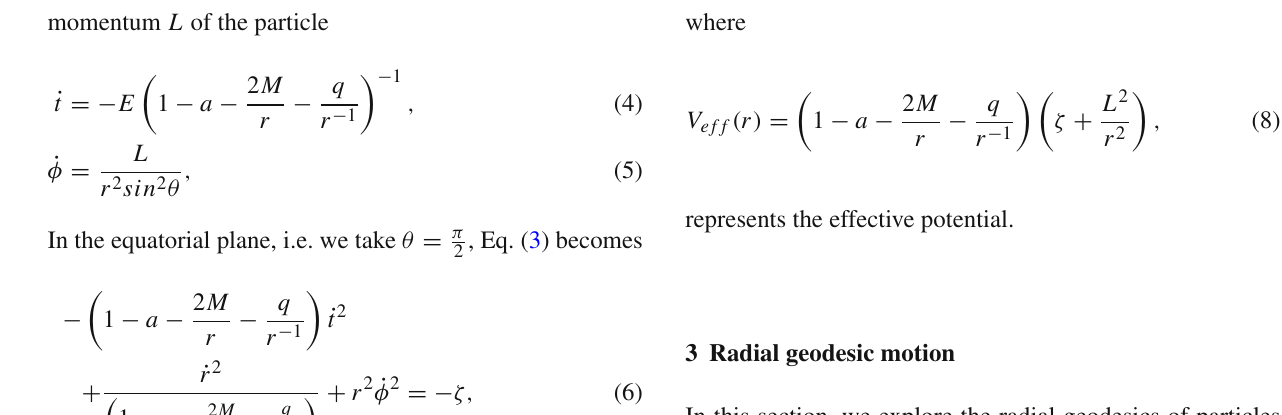
Fig. 2 Shows the graphic analysis of r q in first row and r e in sec- ond row for the different possible values of a and q . The left panel of the first row represents q = 0 . 00007 (blue), q = 0 . 00009 (black), and q = 0 . 00011 (red). The right panel of the first row represents